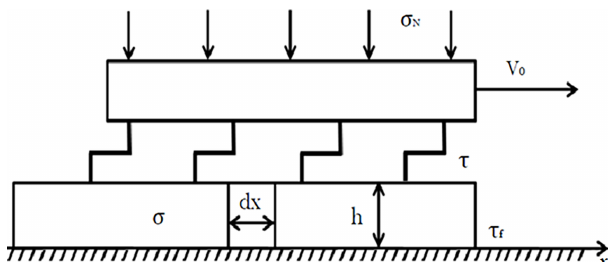
Figure 3. The model of infinitive elastic rod driven by elastic shear spring.